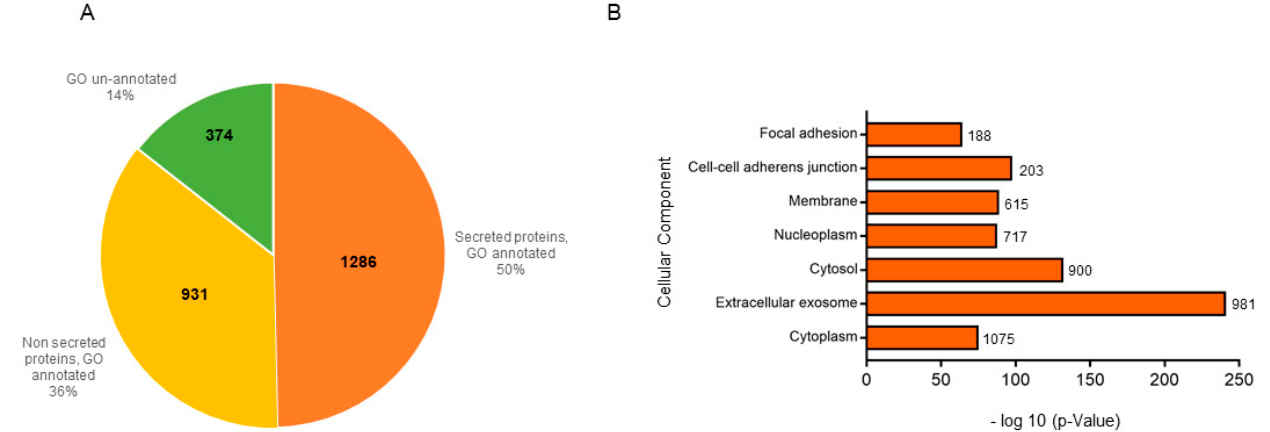
Figure 3. ( A ) Pie-chart of PD cellular component annotation of proteins identified in two secretome samples. ( B ) GO an- notation of the cellular component terms of all the identified proteins vs. their p -values, performed using the DAVID database and the full Homo sapiens proteome as a background. For each term, the corresponding protein count is reported next to the